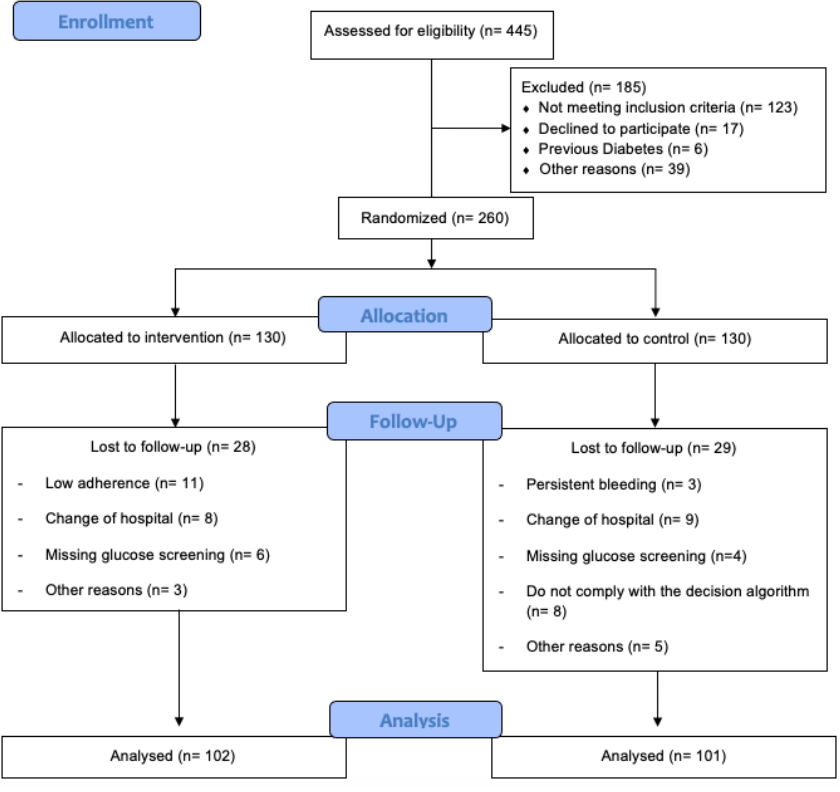
Figure 1. Study population flow chart.